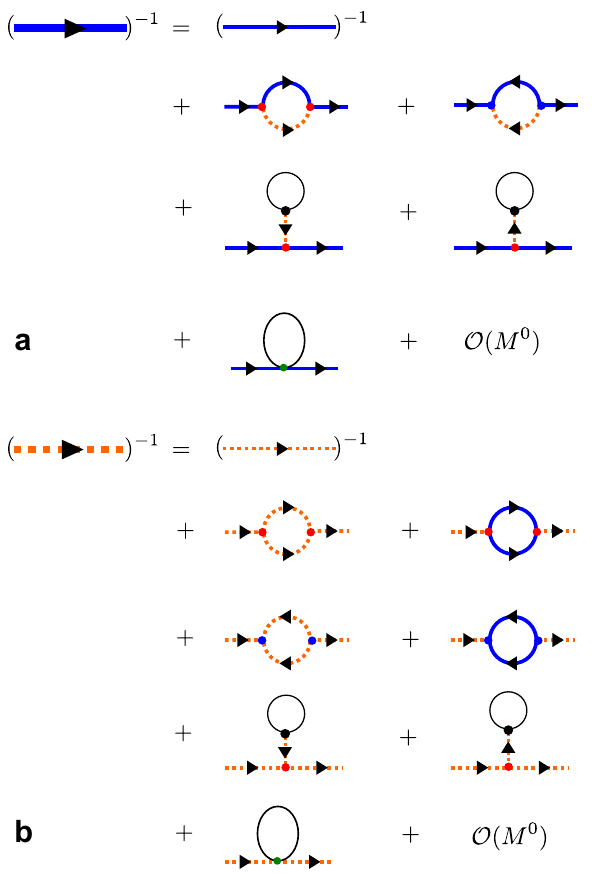
Fig. 6 Diagrammatic representation of the Dyson equation. a One-loop diagrams that contribute up to the order M 0 for the transverse boson. b One-loop diagrams that contribute up to the order M 0 for the longitudinal boson. The dressed propagator is denoted by a thick line, whereas the bare propagator is denoted by a thin line.